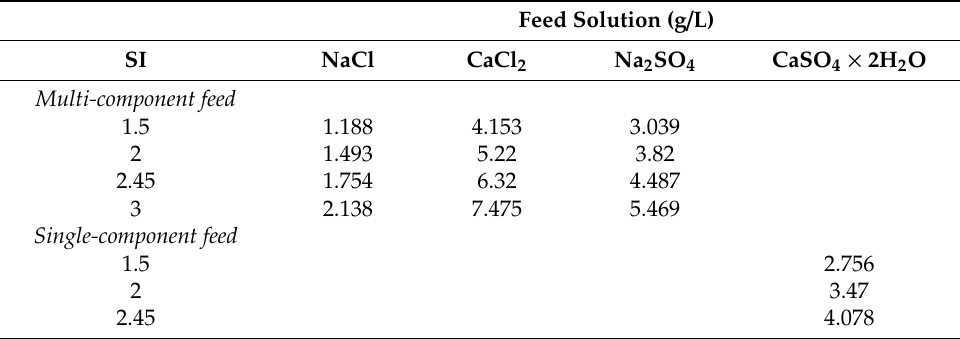
Table 1. Compositions of the feed solutions used in this